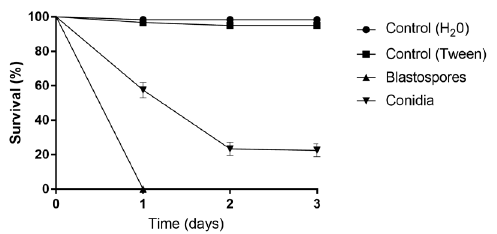
Fig. 1. Survival curves of A. aegypti pupae following exposure to blastospore and conidial suspensions (1x10 7 mL -1 ) during 3 days. Controls group were exposed to distilled water or Tween 20 (0.01%).